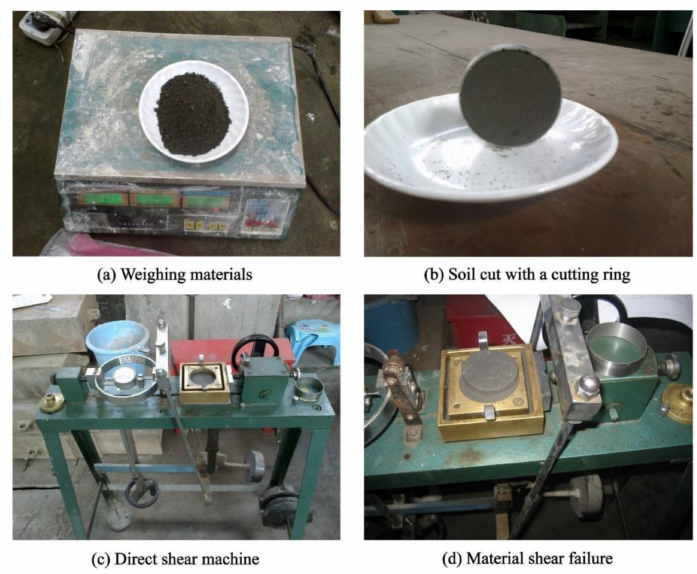
Figure 8. Model material parameter measurement. Table 3. Mechanical parameters of the prototype and scaled model of the surrounding rock. Surrounding Rock